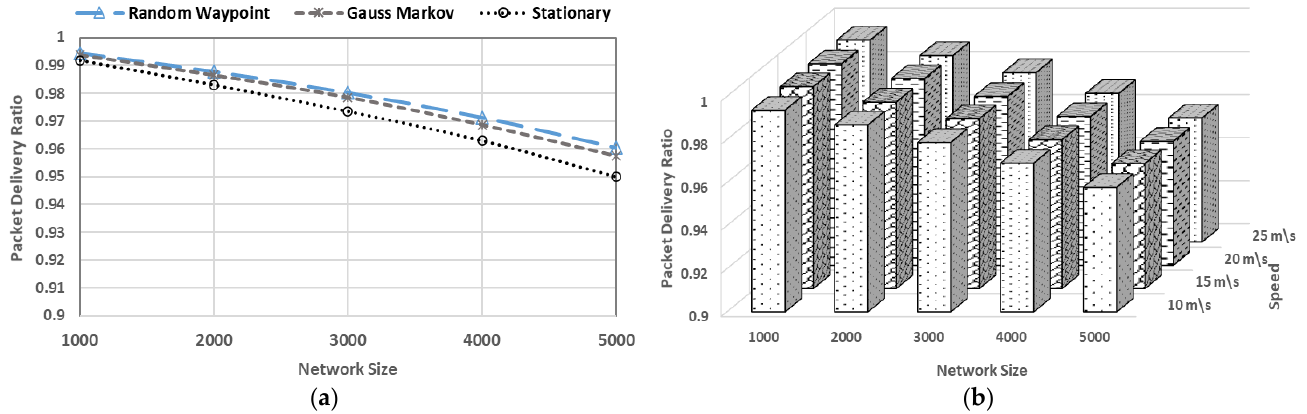
Figure 3. Packet delivery ratio: ( a ) packet delivery ratio for a network with 20 B payload and 5 m / s speed; ( b ) packet delivery ratio for a network with 2000 × 2000 area using the Gauss – Markov mobility model.